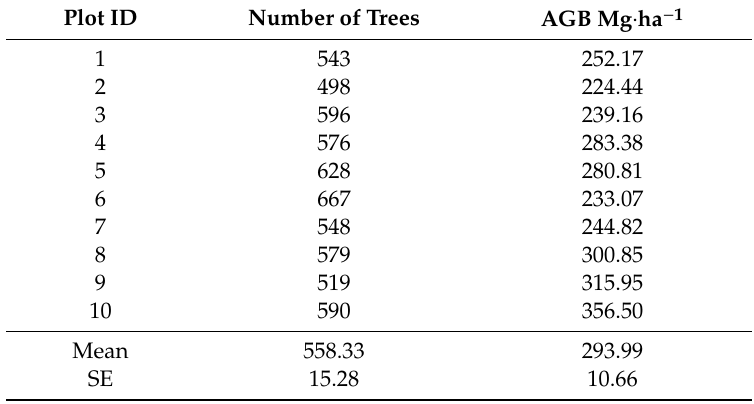
Table 1. Plot identification (ID), number of trees and aboveground biomass (AGB Mg · ha − 1 ) to the permanent sample plots established at the Seringal Filipinas in the Resex Chico Mendes. Plot